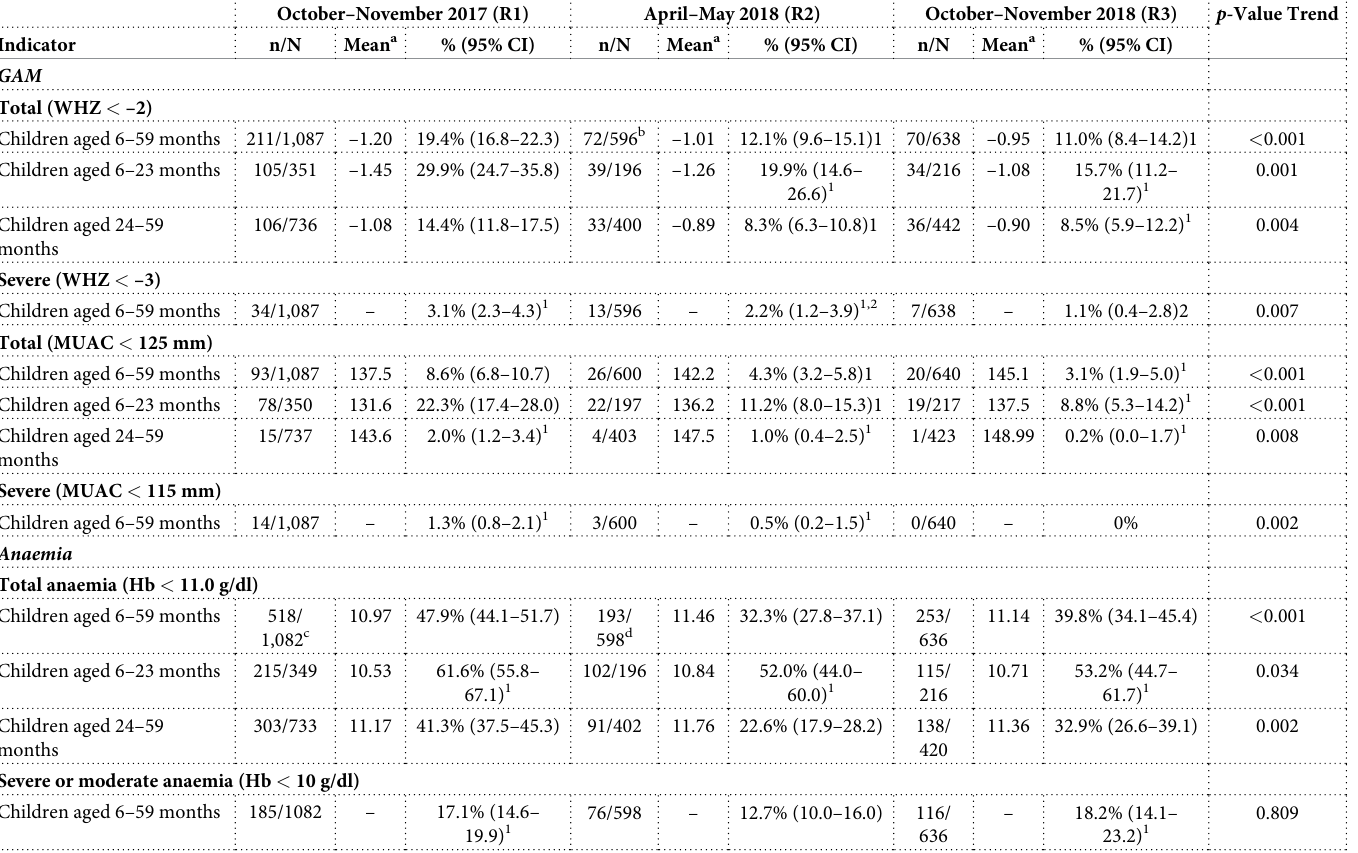
Table 2. Prevalence of GAM and anaemia among Rohingya children 6–59 months of age in makeshift and informal settlements—Bangladesh, 2017–2018.